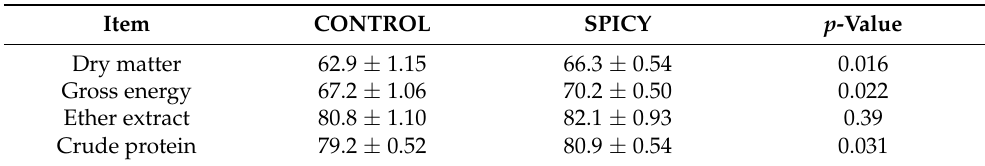
Table 4. Effect of experimental diets fed to broiler chickens on nutrient apparent ileal digestibility (%) at 21 d of age 1 .